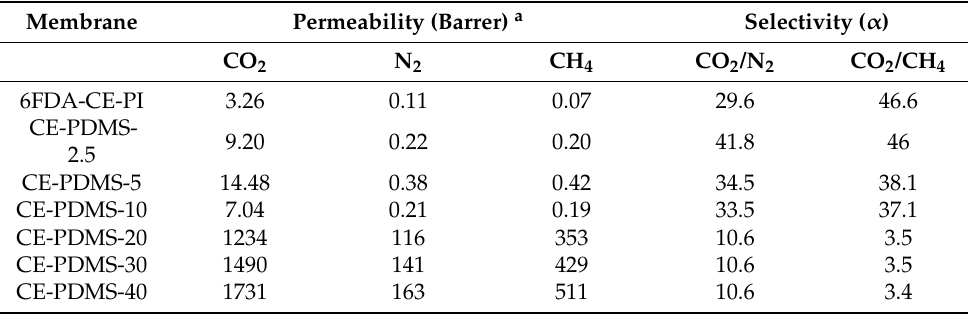
Table 2. Gas permeability and selectivity of CE-PDMS-x membranes.